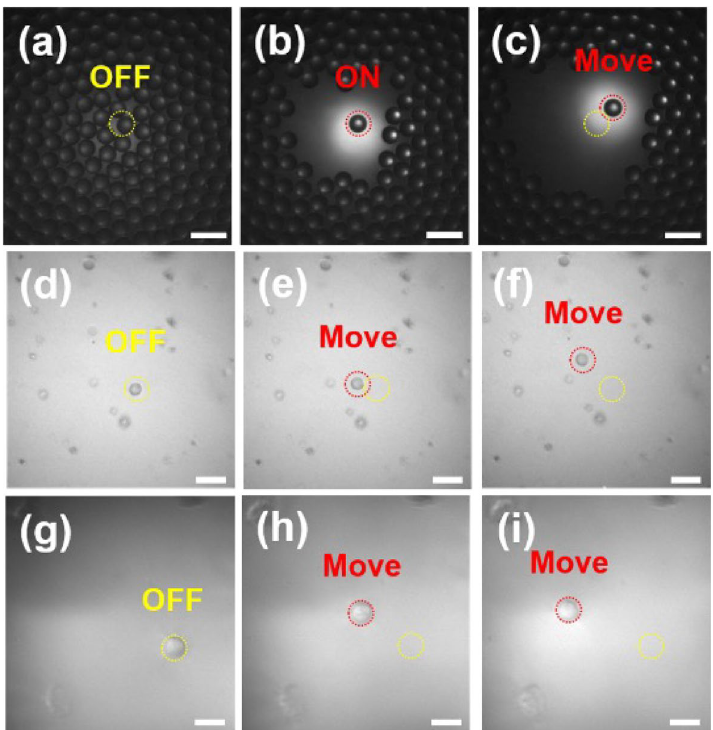
Figure 2. Acoustic trapping of ( a – c ) the targeted single polystyrene microsphere, ( d – f ) RBC, and ( g – i ) PNT1A cell with movement of the high-frequency ultrasound transducer. Yellow and red dashed circles indicate the initial and moved locations of the transducer, respectively. Scale bars in the images indicate ( a – c ) 100 µ m and ( d – i ) 20 µ